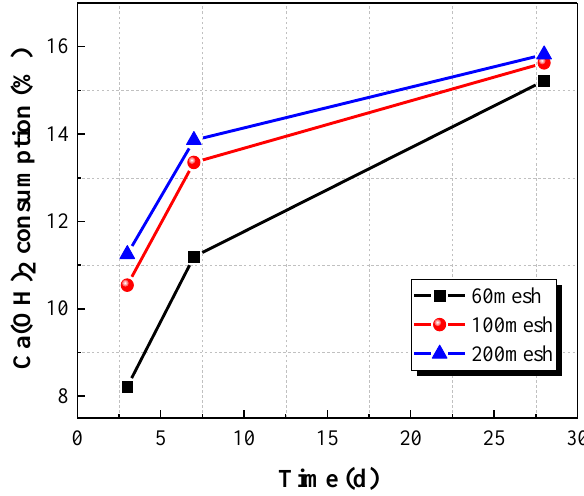
Figure 8. Ca(OH) 2 consumption at different particle fineness. Figure 8 demonstrates that the Ca(OH) 2 consumption increased with the increase in the particle fineness, indicating Ca(OH) 2 consumption can reflect the change in pozzolanic reaction activity caused by different levels of fineness. The particle fineness of CACG powder exerted considerable effects on the early-stage reaction rate (<7d) and the Ca(OH) 2 consumption. However, the developments in later reactions were relatively insensitive to the particle sizes when the fineness exceeded 100 mesh. It is evident that the increase in particle fineness led to a larger contact surface for Ca(OH) 2 and CACG particles, which accelerated the early reaction rate. The Ca(OH) 2 consumption at different calcination temperatures and holding times is shown in Figure 9.